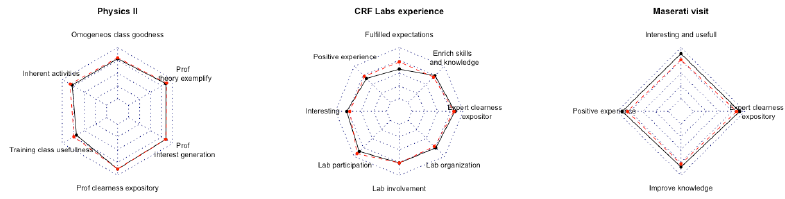
Fig. 8. Radar graph for each activity of the second year for the first 2